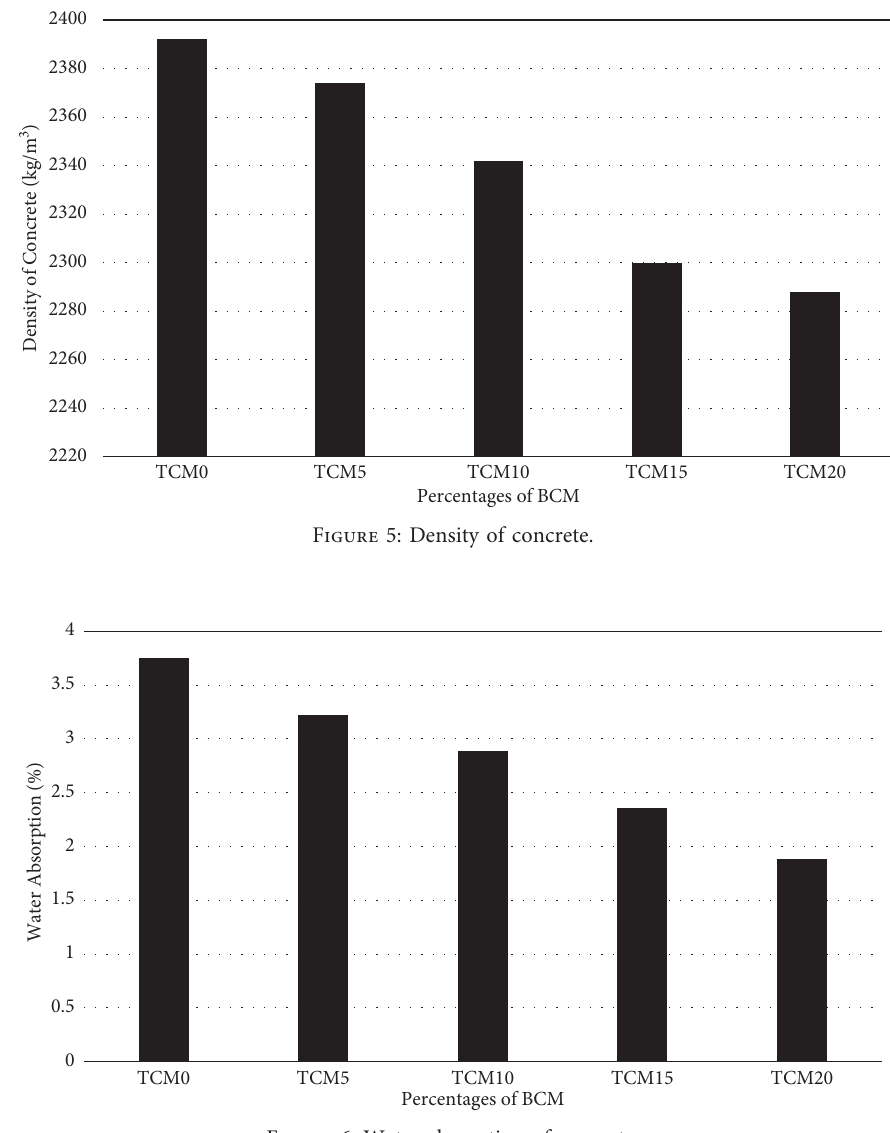
Figure 6: Water absorption of